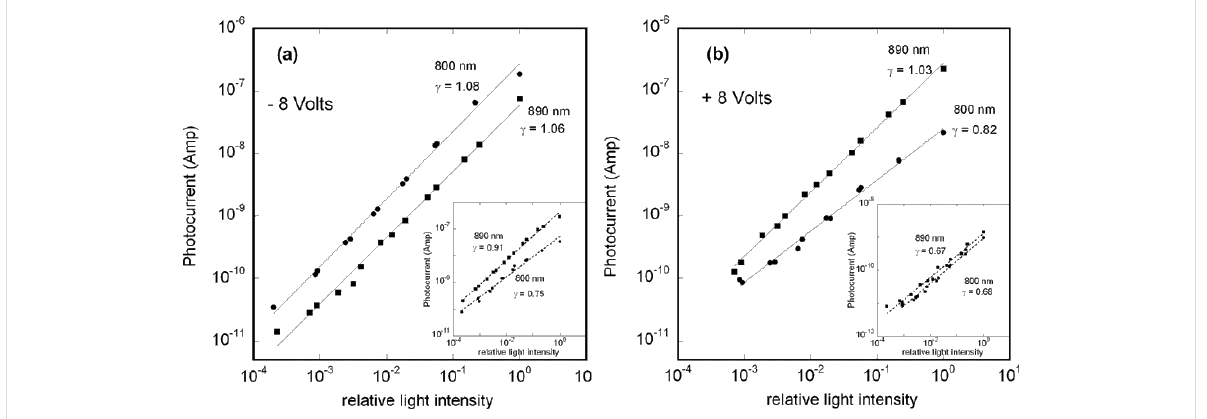
Figure 9: Photocurrent as a function of the relative monochromatic light intensity at λ = 800 and 890 nm for (a) − 8 V and (b) +8 V applied to the top device contact. The best power-law fits are shown along with the resulting exponent γ . The full light intensity was approximately 10 − 5 W/cm 2 . In the insets (a) and (b) the results obtained for a similar device without CNTs (ITO/GaAs/Ti/Au) under the same experimental conditions are shown for com- parison.